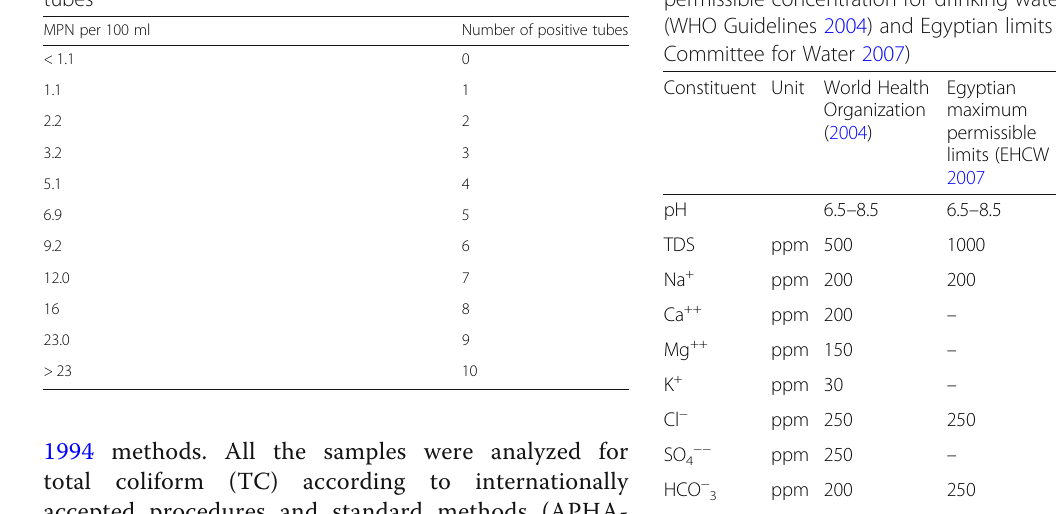
Table 2 Standard most probable number (MPN) table for ten tubes